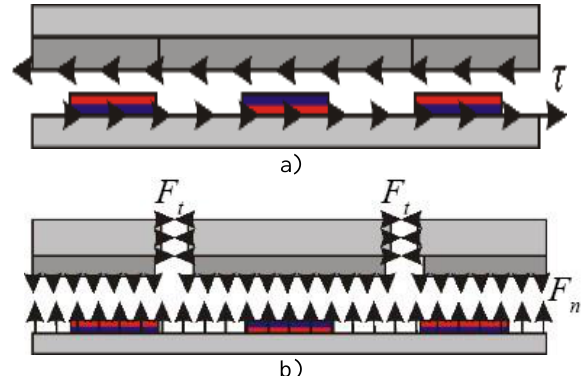
Fig. 3. Structural forces in the machines: a) the shared stress, the useful air-gap force that gives the machine torque; b) normal component of Maxwell stress, the forces trying to close the